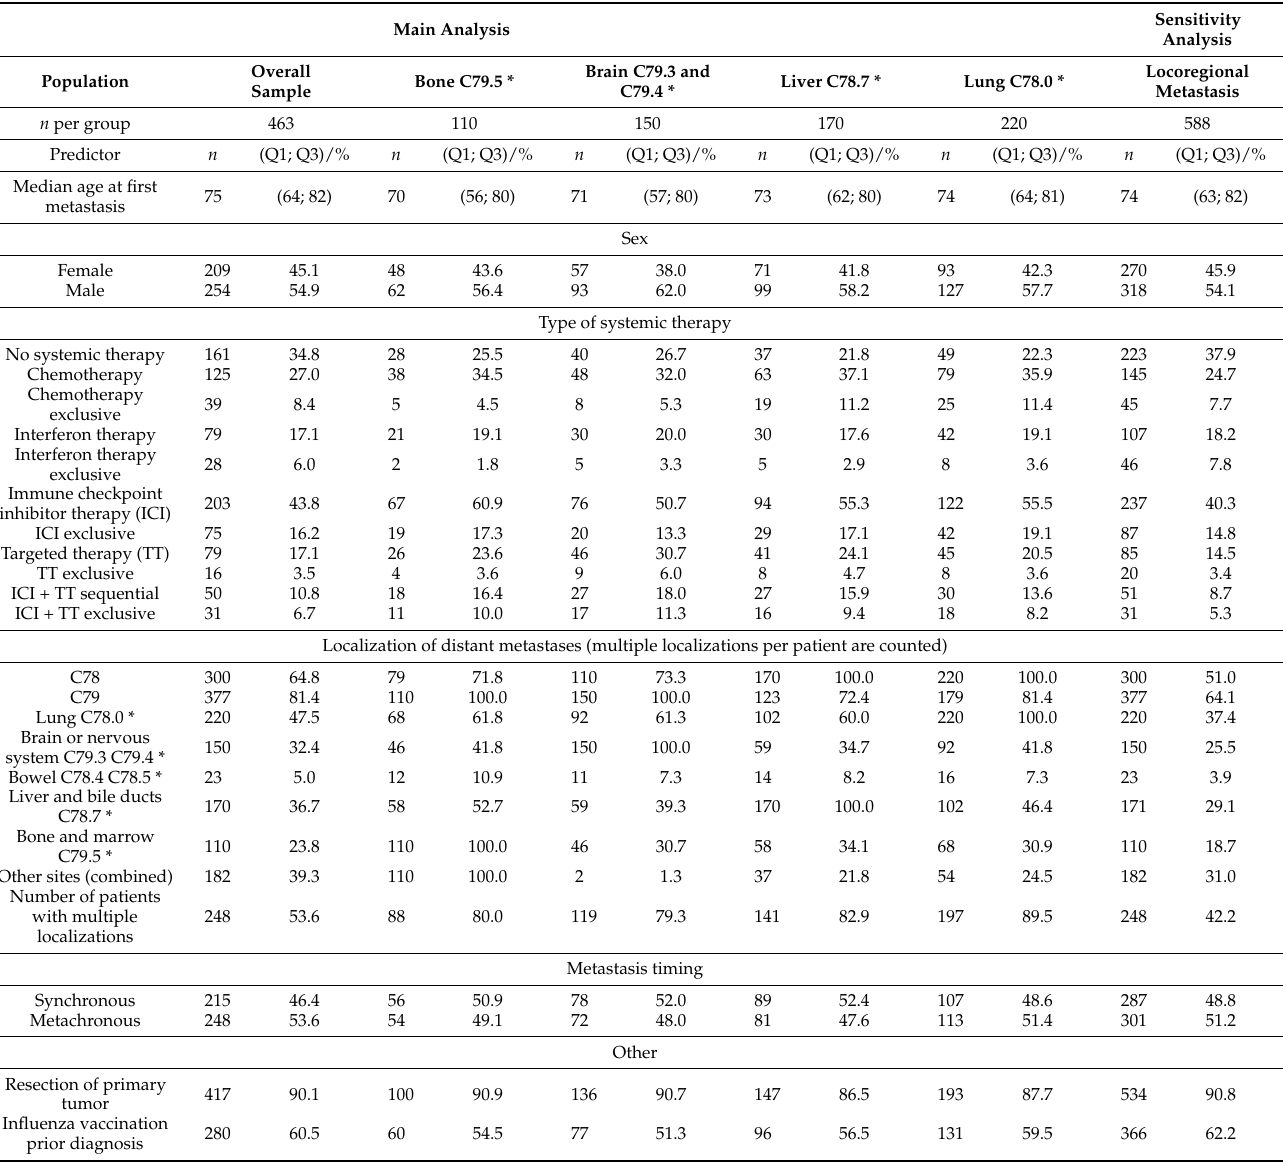
Table 1. Information on study cohort and subgroups with different types of metastasis. Main